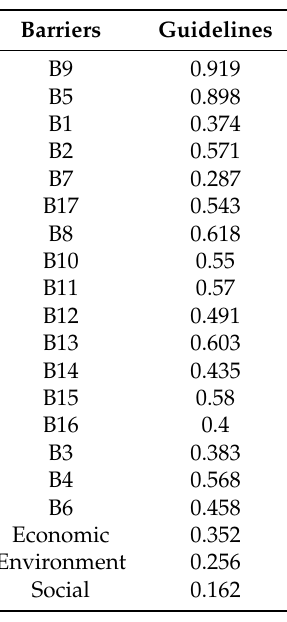
Table 6. Cross loadings results.